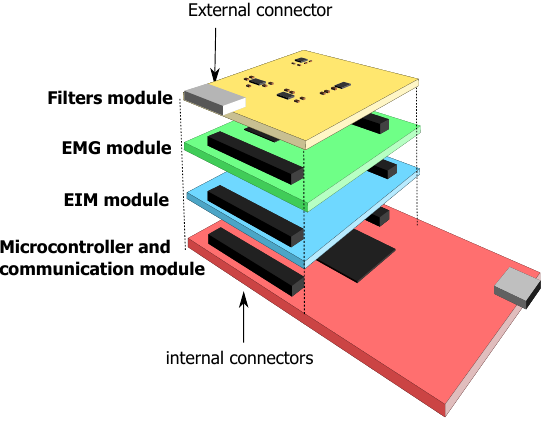
Figure 2. The modular hardware design.